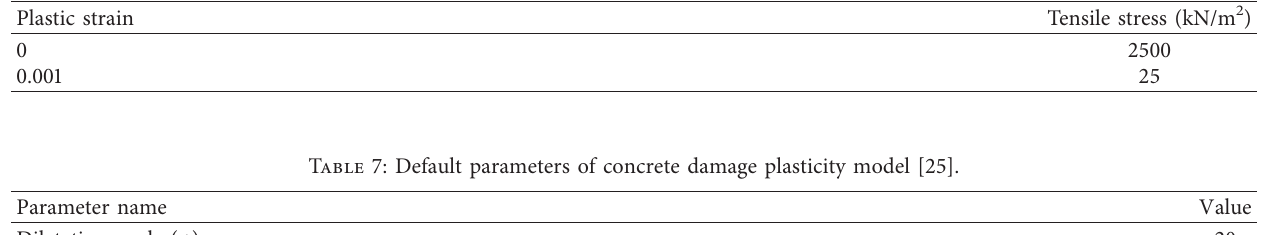
Table 6: The nonlinear tensile properties of concrete in concrete damage plasticity model [25].